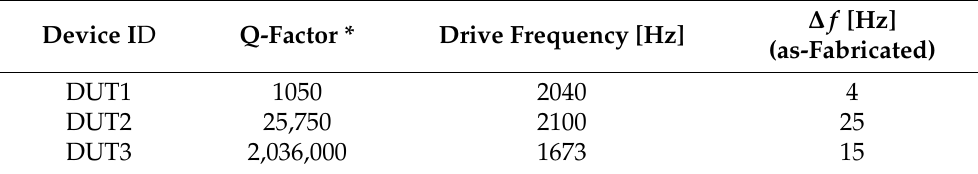
Table 2. Characteristics of the three sensors used for the noise performance